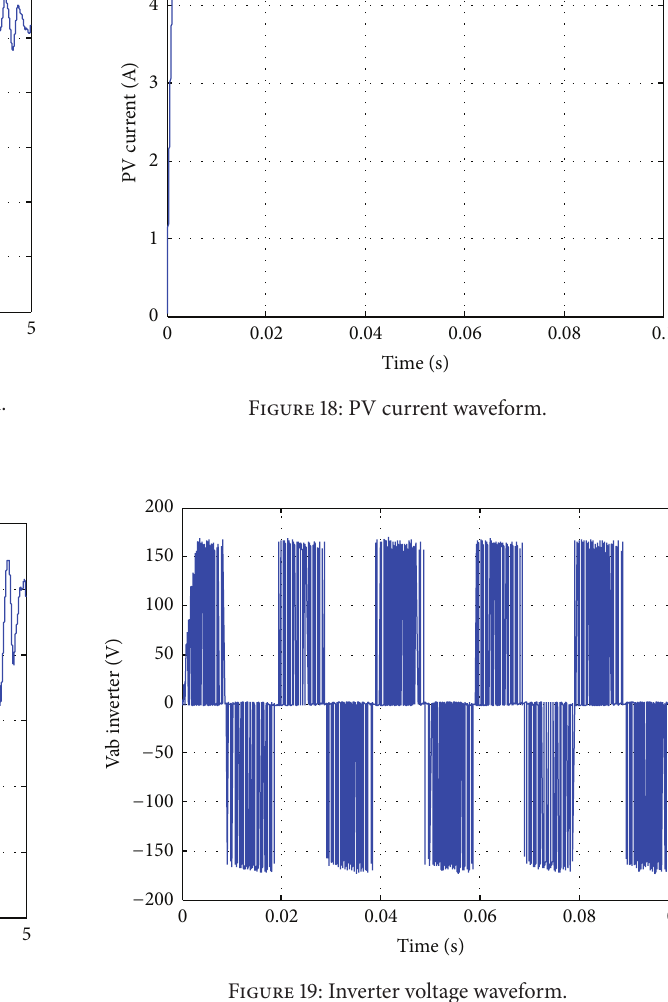
Figure 16: Variation of PV array power in time domain.